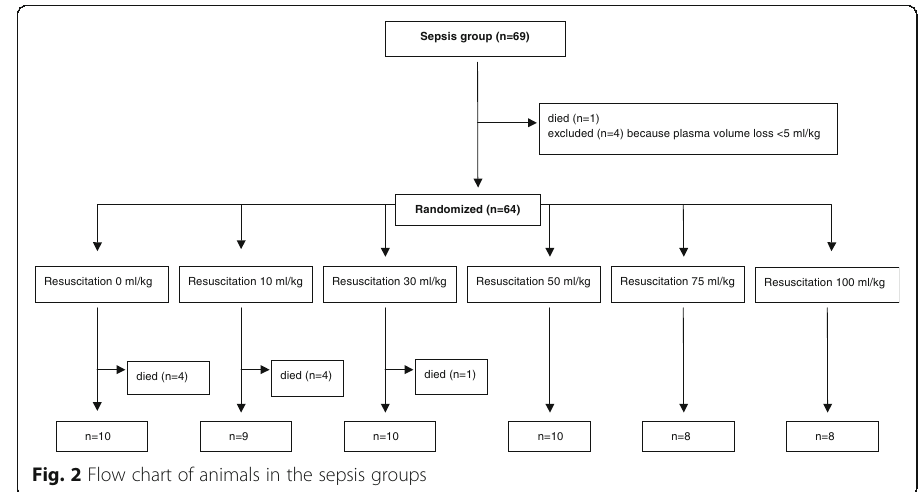
Fig. 2 Flow chart of animals in the sepsis groups